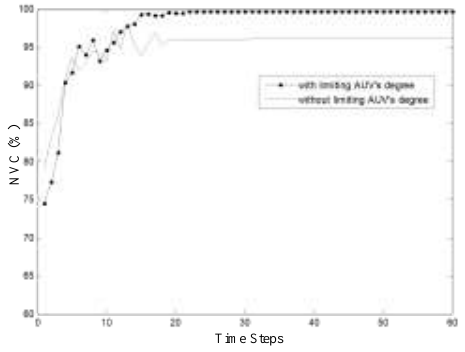
Figure 8. NVC vs. time step with and without limiting AUV's degree.